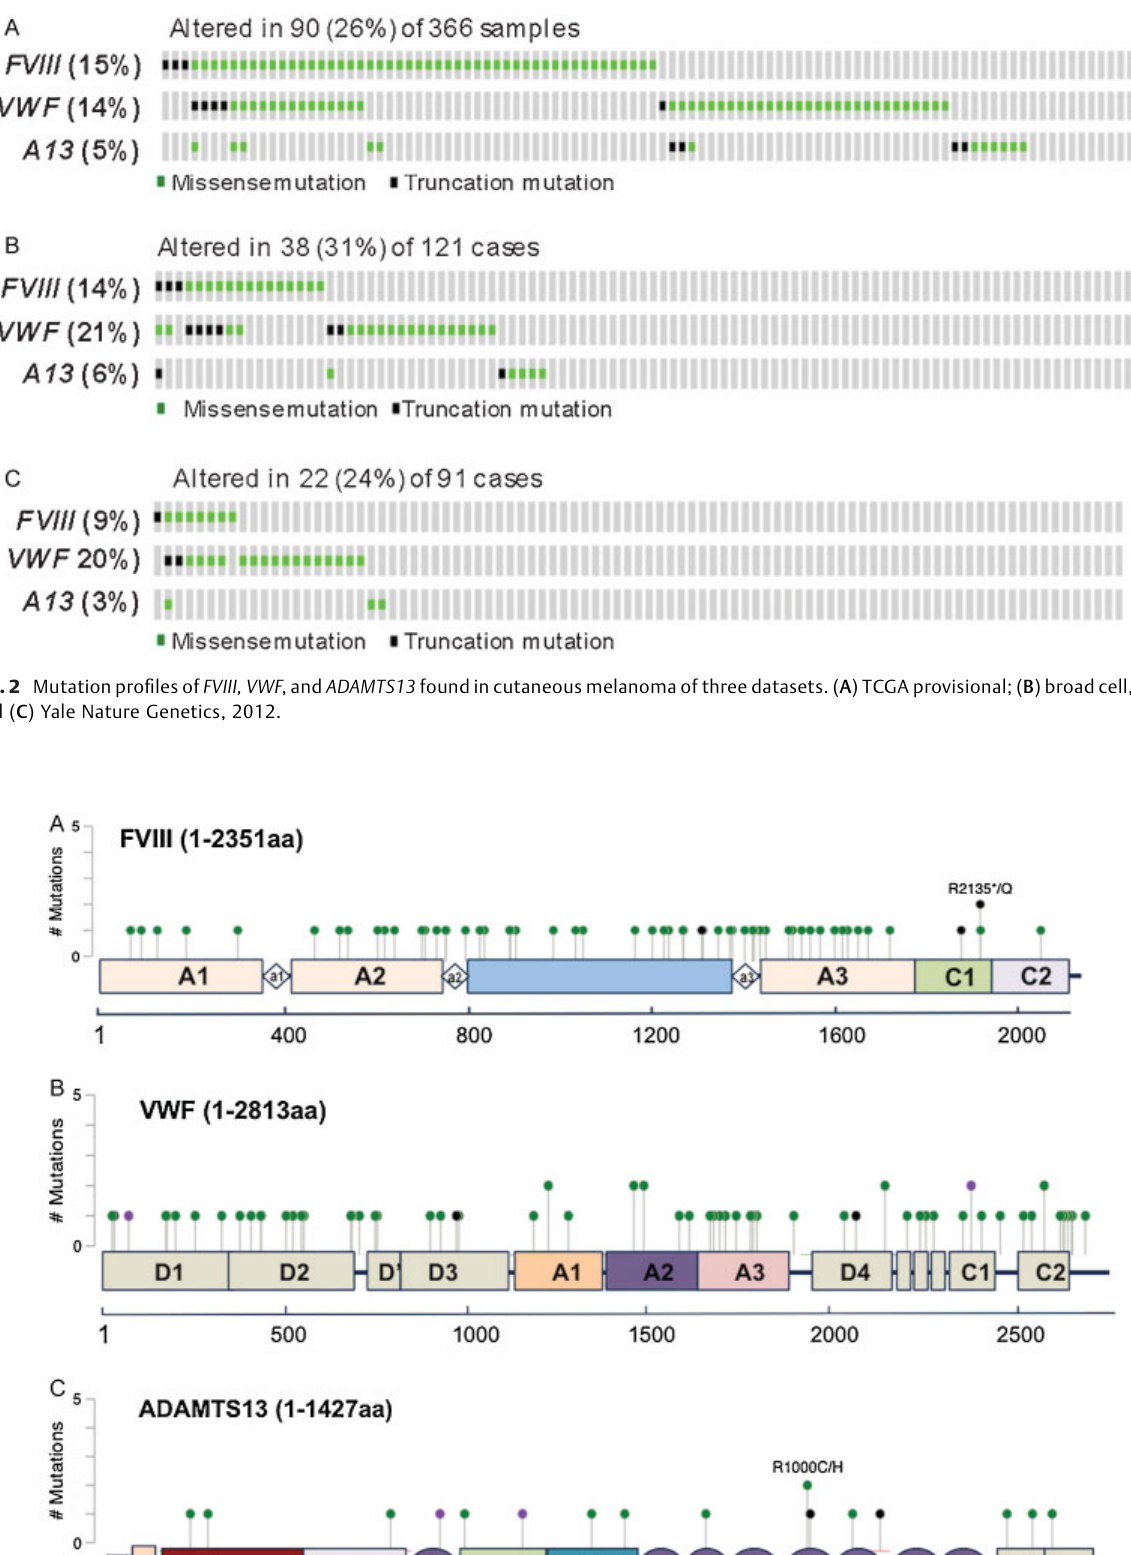
TH Open Vol. 1 No.